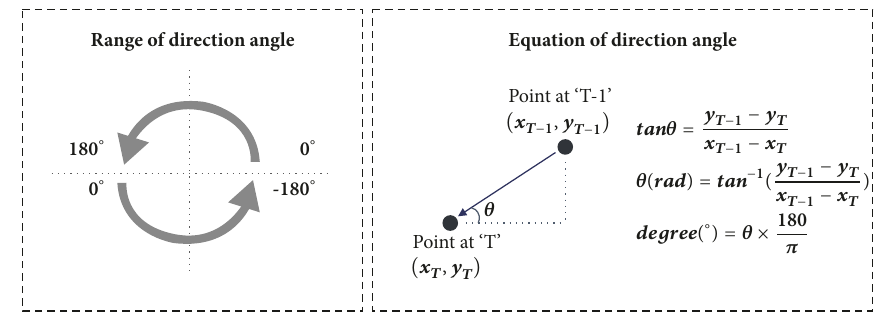
Figure 5: Concept and equation of the direction angle. The range of the SDD, or comfortability value, is from − 180 ∘ to +180 ∘ depending on quadrant